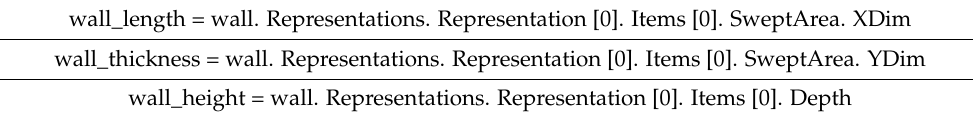
Table 4. Wall Parameters for its Length, Thickness, and